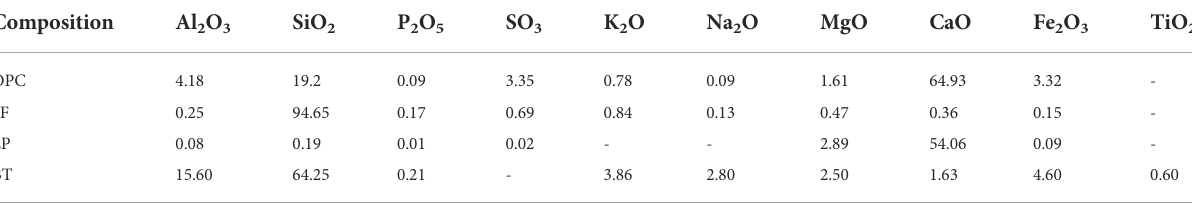
TABLE 1 Chemical composition of cementitious materials (wt%).